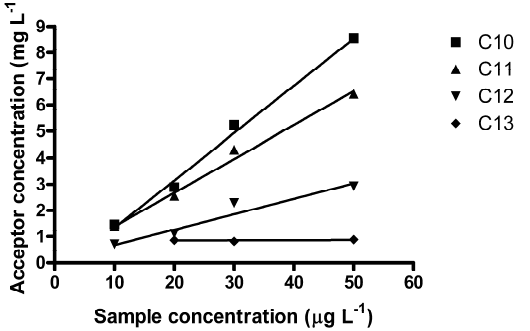
Figure 4. Acceptor concentration as a function of low LAS sample